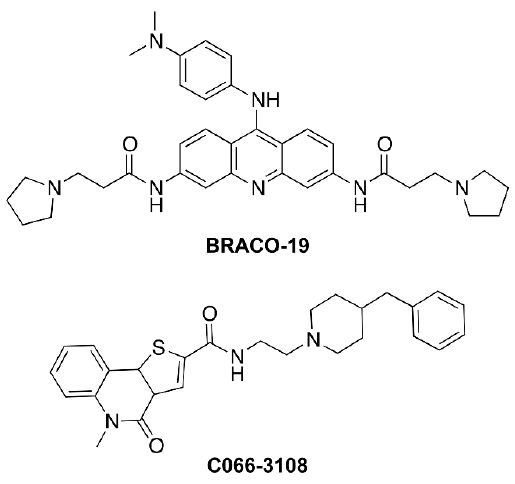
Figure 1. Chemical Structure of C066-3108 and BRACO-19. The chemical structure of C066-3108 and BRACO-19 is